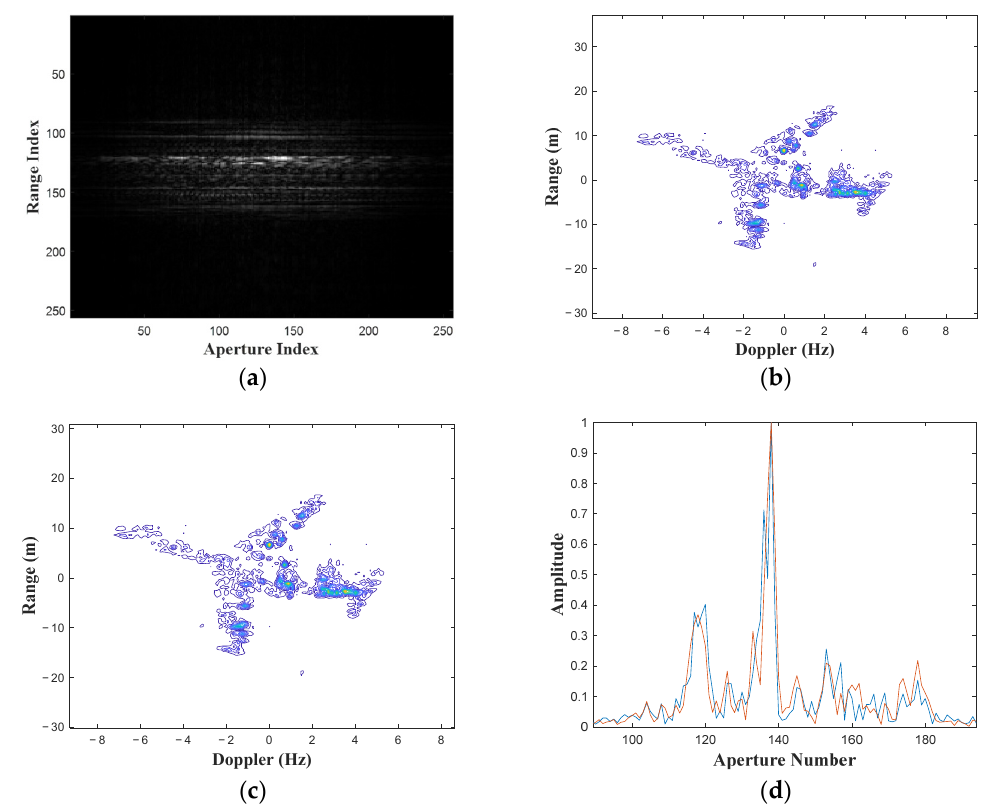
Figure 11. Real data results. ( a ) Range profiles. ( b ) ISAR image with the RD method. ( c ) Recovered image using the KF-tracking method. ( d ) The 125th range cells of the recovered images.